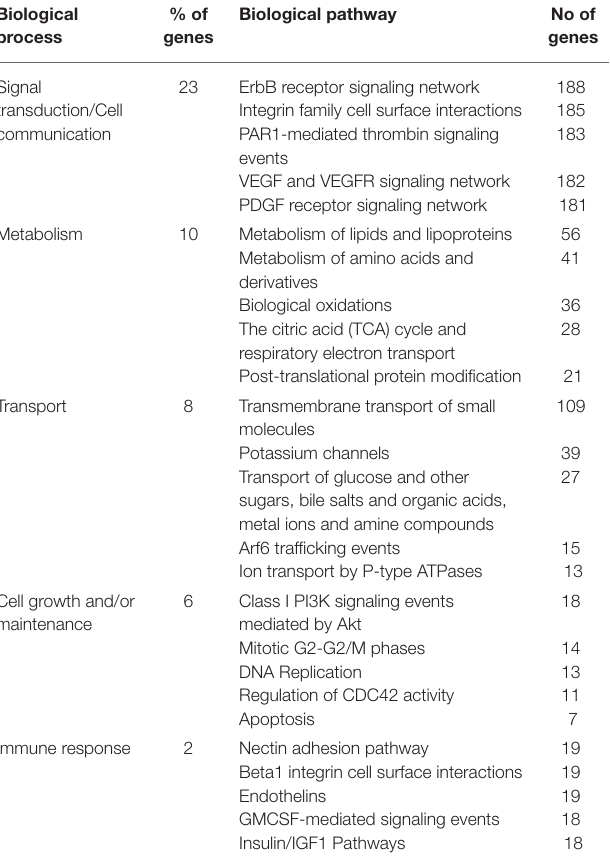
TABLE 4 | Top 5 biological processes and relative pathway annotations for DEGs between all tumor compartments and control tissue. Biological % of Biological pathway No of process genes